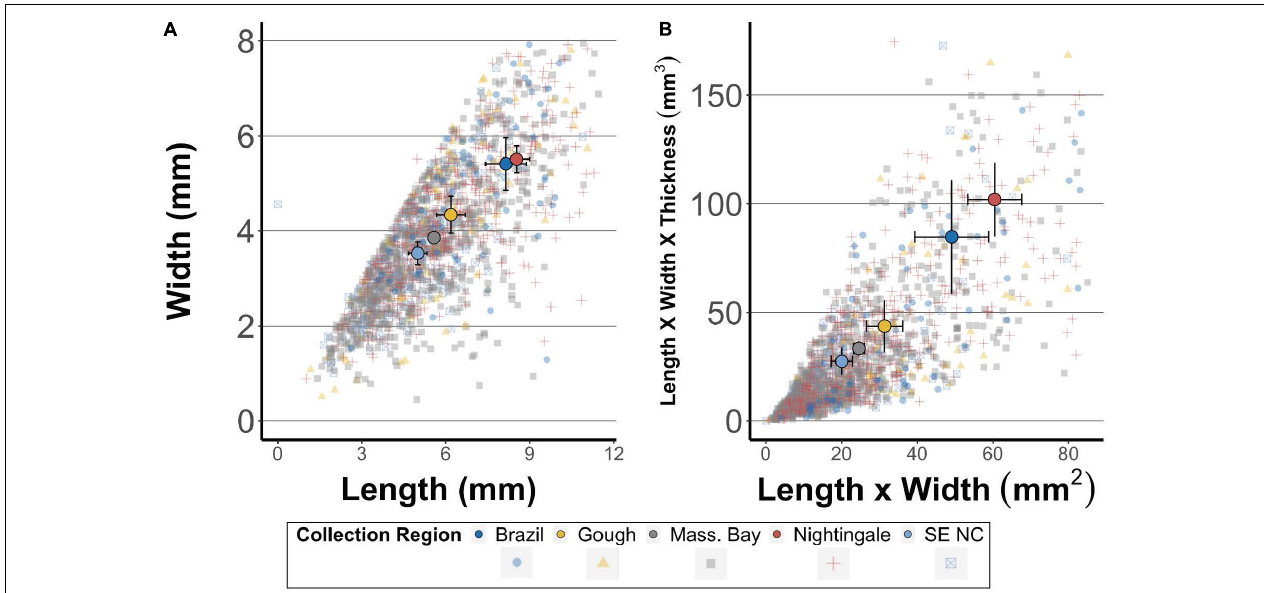
FIGURE 4 | (A) Length and width and (B) length × width and length × width × thickness of plastic fragments found in digestive tracts of Great Shearwaters Ardenna gravis . Colors and shapes indicate collection region. 95% of the data is displayed, with the upper 5% omitted for data and axis legibility. Bold circles in each plot present the mean, and associated error bars present 95% confidence intervals. SE NC = Southeast North Carolina, United States. Mass. Bay = Massachusetts Bay, United